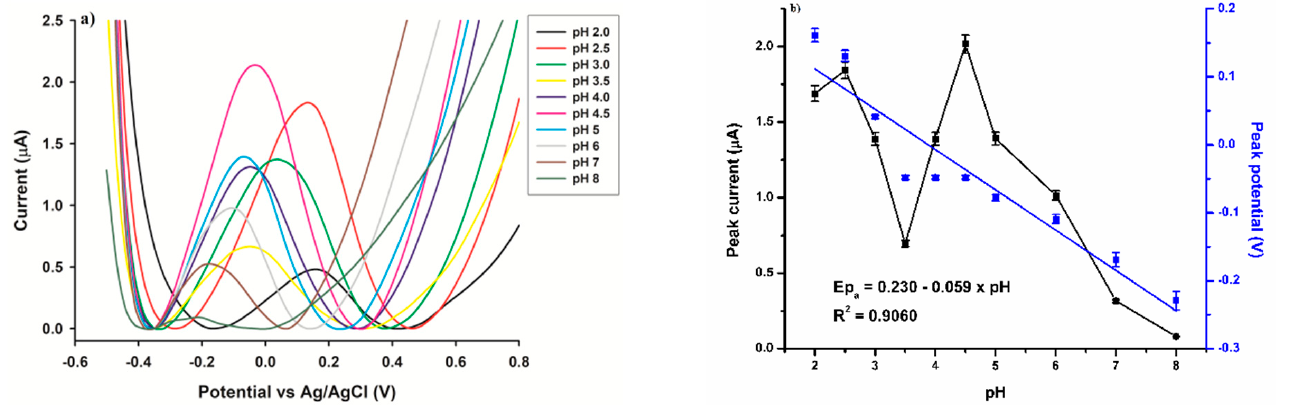
Figure 4. ( a ) Square wave voltammograms of 1.0 × 10 − 4 mol L − 1 Na 2 S 2 O 5 using the TPP/rGO@Pd0 sensor in PBS at pH values 2.0 − 8.0. ( b ) The effect of the pH on the peak current (black dots) and the linear dependence of the peak potential with the pH (blue line) .